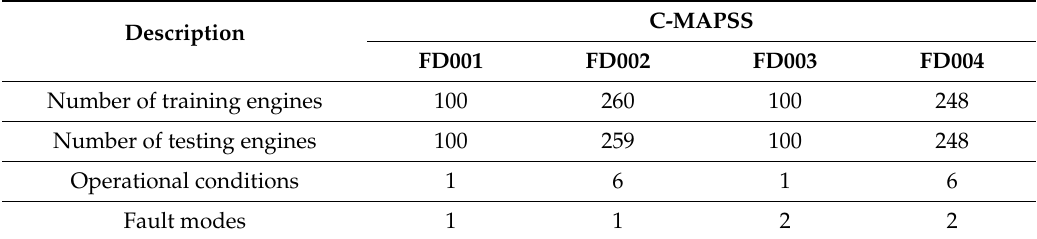
Table 1. Commercial Modular Aero-Propulsion System Simulation (C-MAPSS) dataset description [38]. C-MAPSS Description FD001 FD002 FD003 FD004 Number of training engines 100 260 100 248 Number of testing engines 100 259 100 248 Operational conditions 1 6 1 6 Fault modes 1 1 2